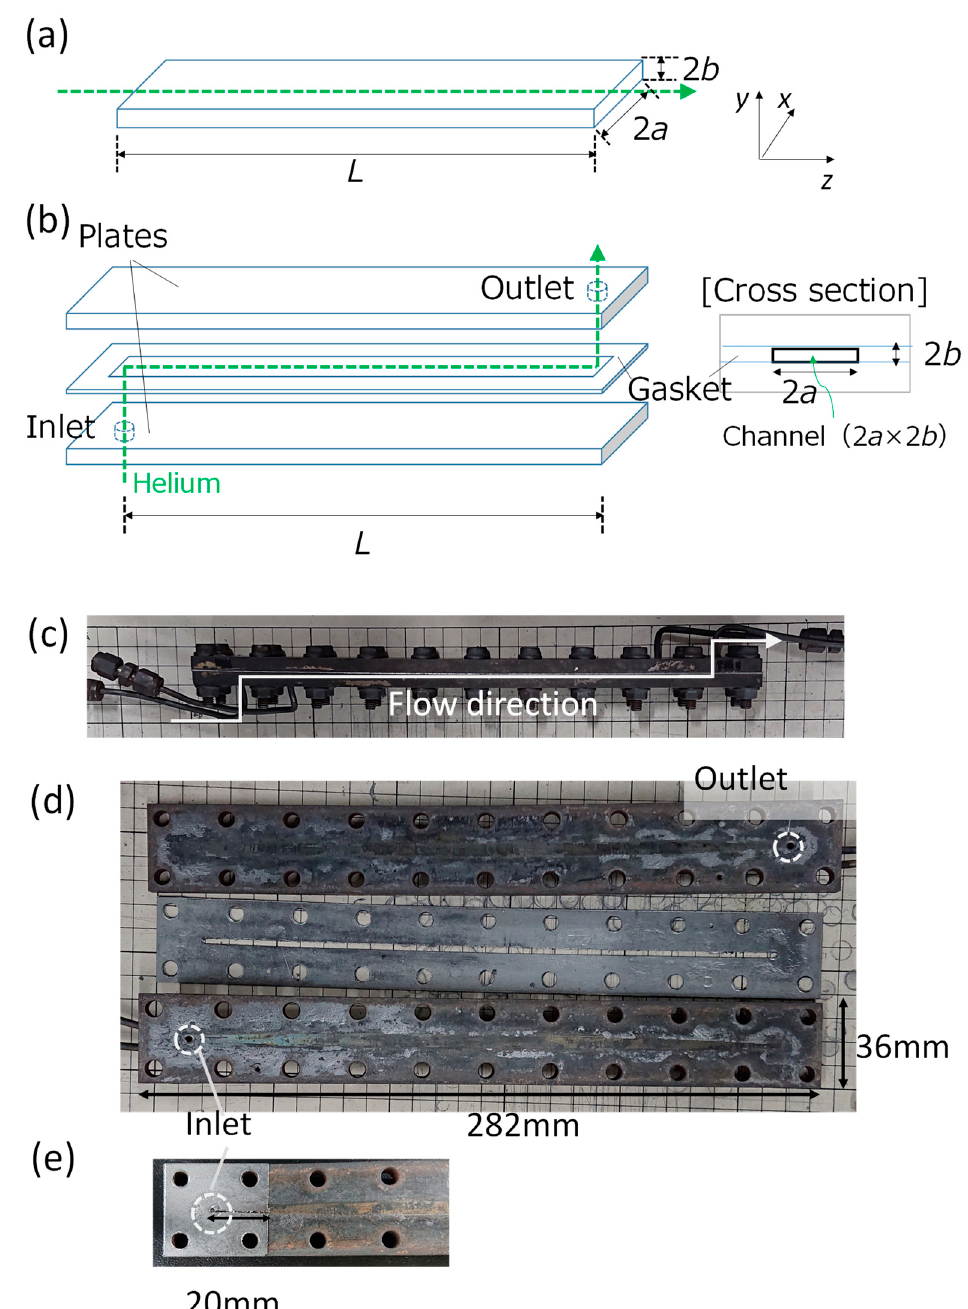
Figure 1. Structure of plate reactor with a rectangular channel: ( a ) geometry for 3D CFD simulation, ( b ) perspective view of the device used in the experiment, ( c ) an assembled plate reactor used in this work, ( d ) stainless steel plates and gasket with the rectangular slit before assembling, ( e ) cut gasket for measurements of fluid resistance at the inlet and the outlet.